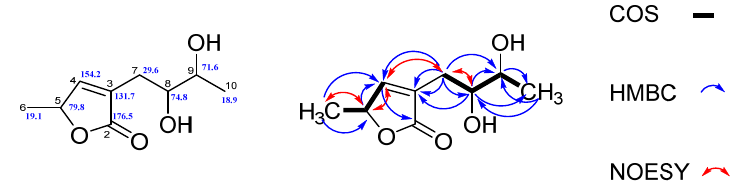
Figure 2. Signal assignments of compound 4 via 13 C and 2D NMR.